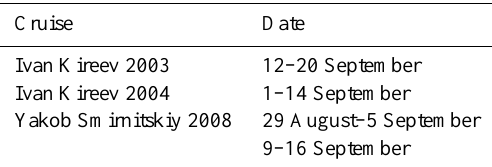
Table 1. Dates of cruises in the